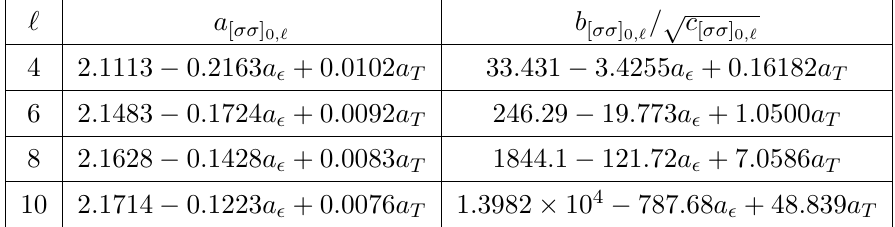
[ (cid:27)(cid:27) ] 0 ;‘